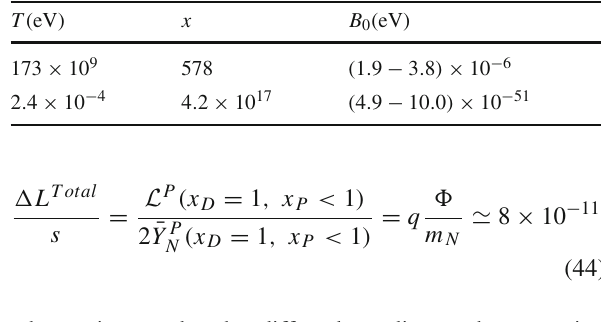
Table 2 A table showing the different values of the background field B 0 in the temperature regimes where the quarks fall out of equilibrium (first line) and the value today (second